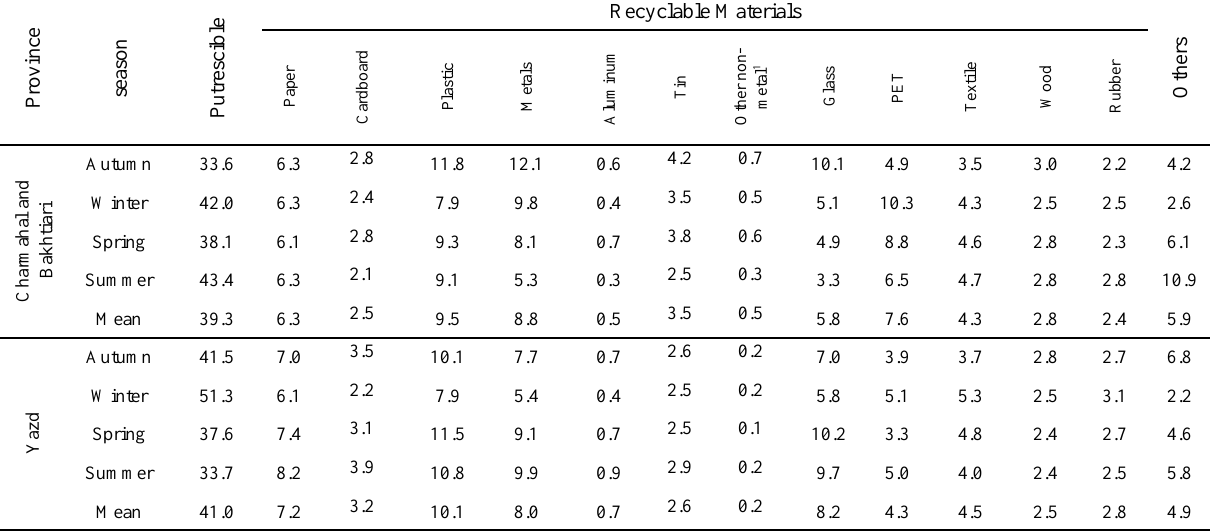
Table 1. Physical analysis of waste in rural areas of the